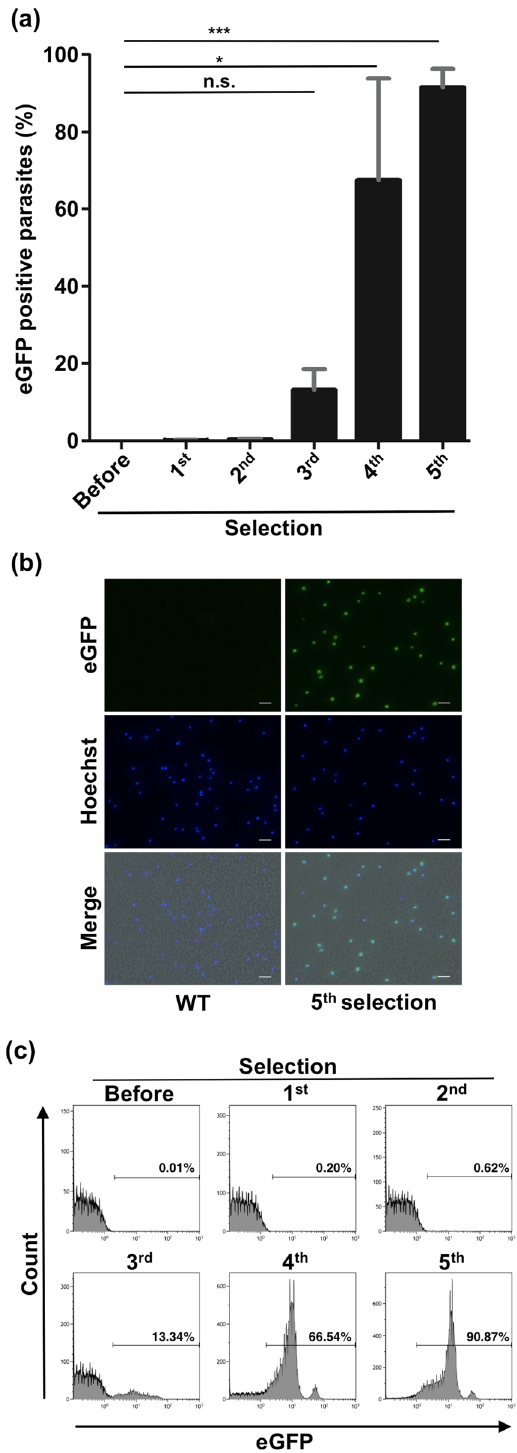
Figure 6. Application of the hdhfr -WR99210 system to in vitro selection. ( a ) eGFP-positive parasite ratio transfected with pXL/hdhfr-pac-egfp (Fig. 2a) after each WR992210 selection, analyzed using fluorescence microscopy. Each bar represents the mean ± SD of three independent experiments. * p < 0.05, *** p < 0.001, n.s.: not significant (paired t -tests). ( b ) Fluorescence images of WT and parasites after the fifth selection containing the hdhfr marker. Parasites were stained with Hoechst 33342. WT: wild type. The scale bar represents 10 µ m. ( c ) Flow cytometry analysis of eGFP positive mutant ratio after each WR99210 selection. Numbers above bracketed lines indicate percent parasites with eGFP